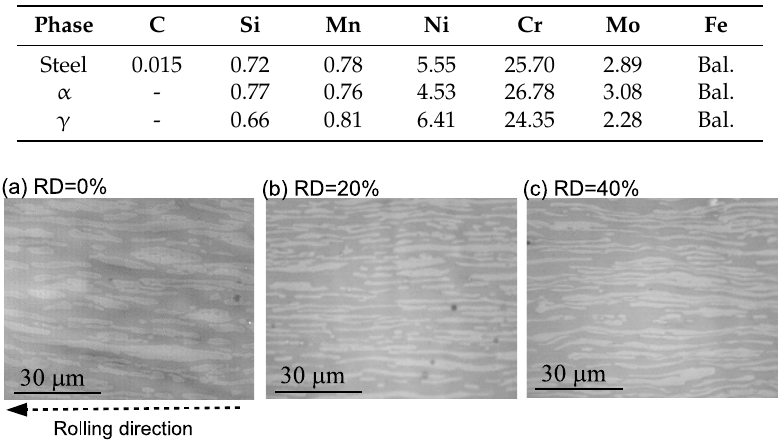
Figure 7. Optical microscope images, taken after ( a ) 0%, ( b ) 20%, and ( c ) 40% rolling reduction. Dark and light grays denote bcc ferrite ( α ) and fcc austenitic ( γ ) phases, respectively.